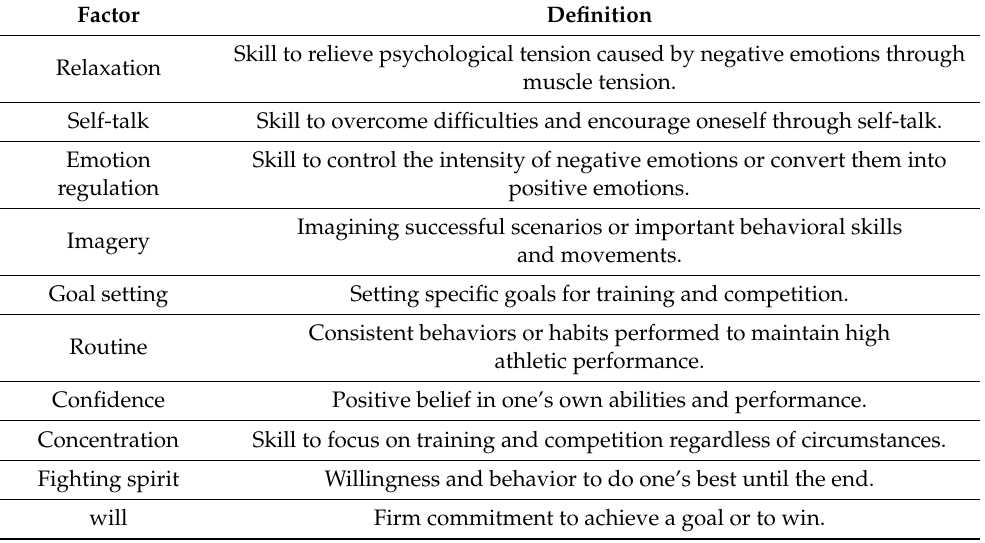
Table 4. Taekwondo Athletes’ 10 Key Sport Psychological Skills.